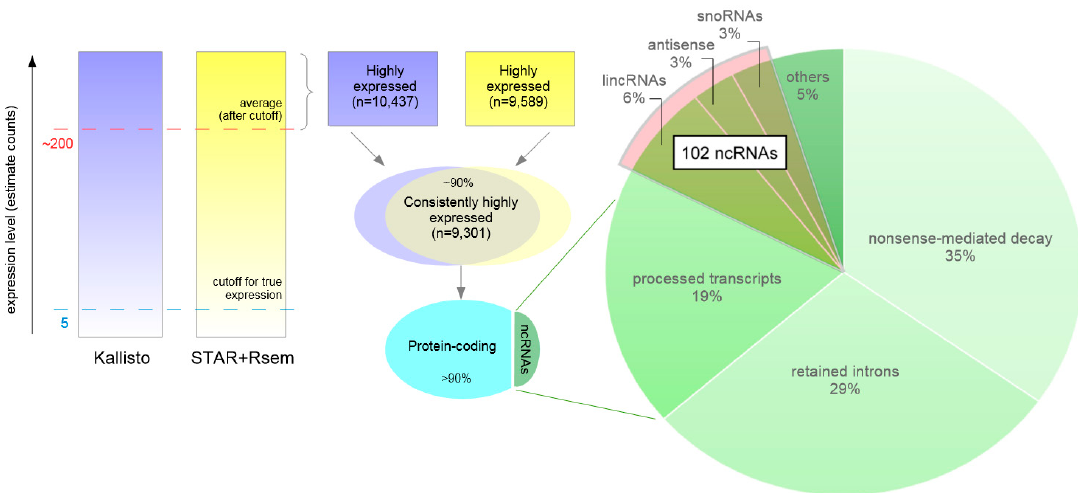
Figure 6. Transcripts that are highly expressed in activated neurons. Strategy used to assess transcripts with high expression in activated neurons. Transcript abundance is estimated by Kallisto (purple) and STAR+RSEM (yellow). The color intensity represents expression level in estimated counts. A lower limit for expression confidence was established at 5 counts (blue dashed line). To be considered highly expressed the average number of estimated counts was above approximately 200 (red dashed line). There were approximately 10,000 highly expressed transcripts defined by each method, more than 9000 of which were consistently reported by both methods. From these, approximately 10% were ncRNAs, a total of more than 800 transcripts. The pie chart represents the distribution of these ncRNAs in their molecular classes and highlights the set of 102 highly expressed ncRNAs, described in more detail in the text, in which a higher degree of functional data is available. lincRNA: large intergenic non-coding RNA; snoRNA: small nucleolar RNA.